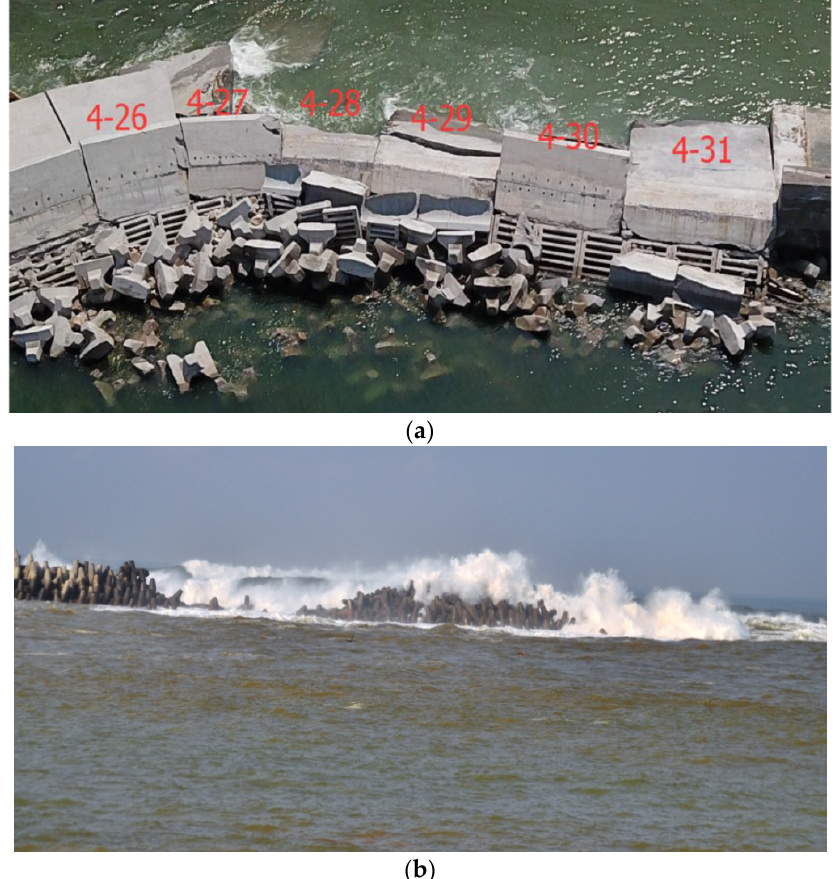
Figure 1. Site damage and instability of breakwater: ( a ) damage of transition zone of different structures of breakwater; ( b ) damage of breakwater head with the same structure.